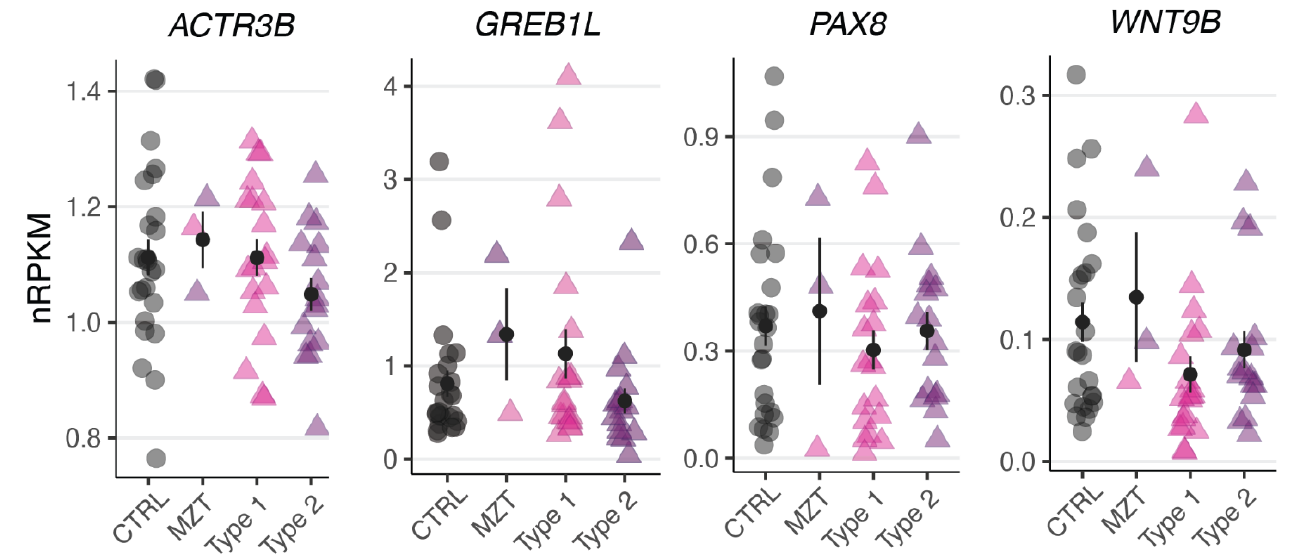
Figure 2. No significant change in genes expression observed for ACTR3B , GREB1L , PAX8 , and WNT9B . Expression levels for the selected DEGs plotted as individual data points with mean ± SEM.